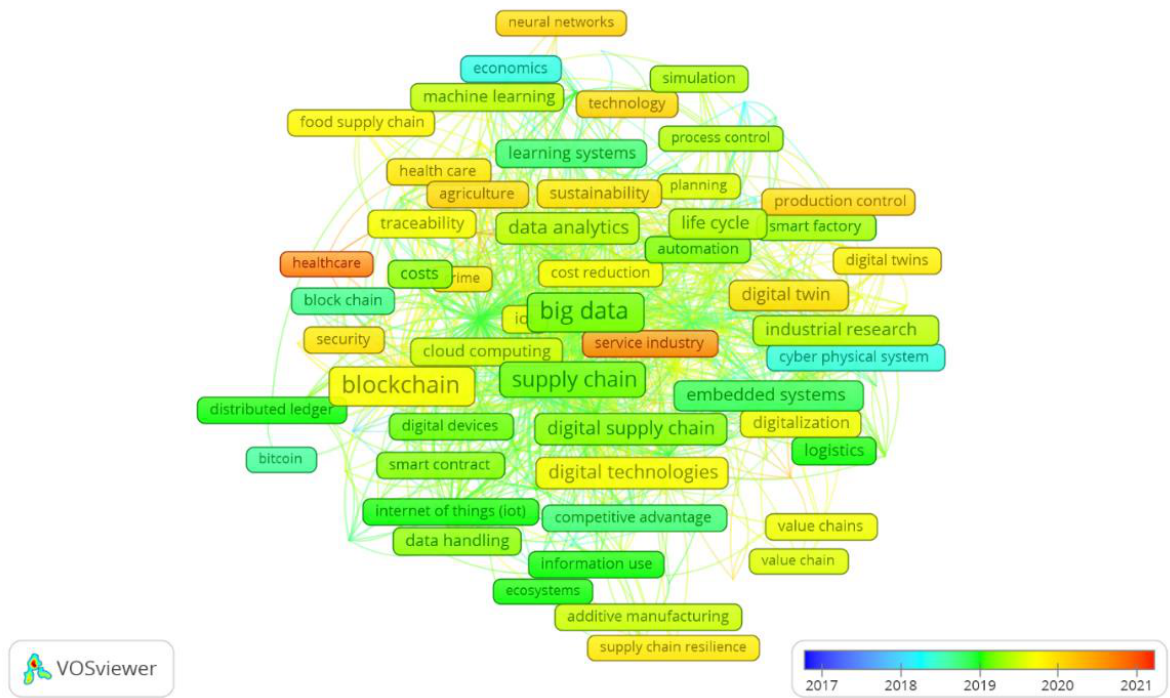
Figure 11. Keyword overlay visualization by VOS viewer software.